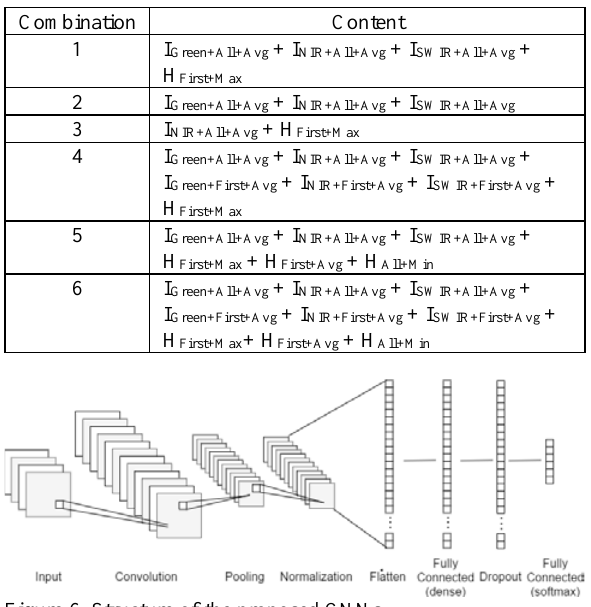
Figure 6. Structure of the proposed